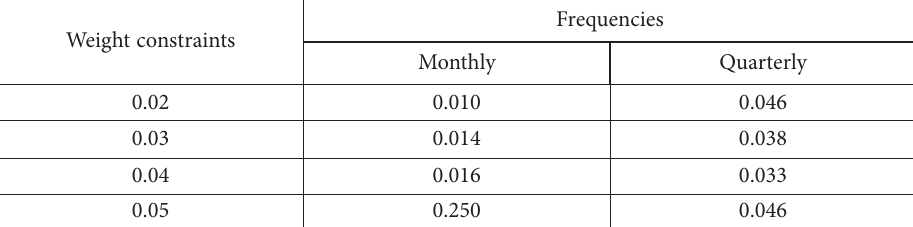
Table 15. Comparison of P values under different weight constraints (sample size is 100) Frequencies Weight constraints Monthly Quarterly 0.02 0.010 0.046 0.03 0.014 0.038 0.04 0.016 0.033 0.05 0.250